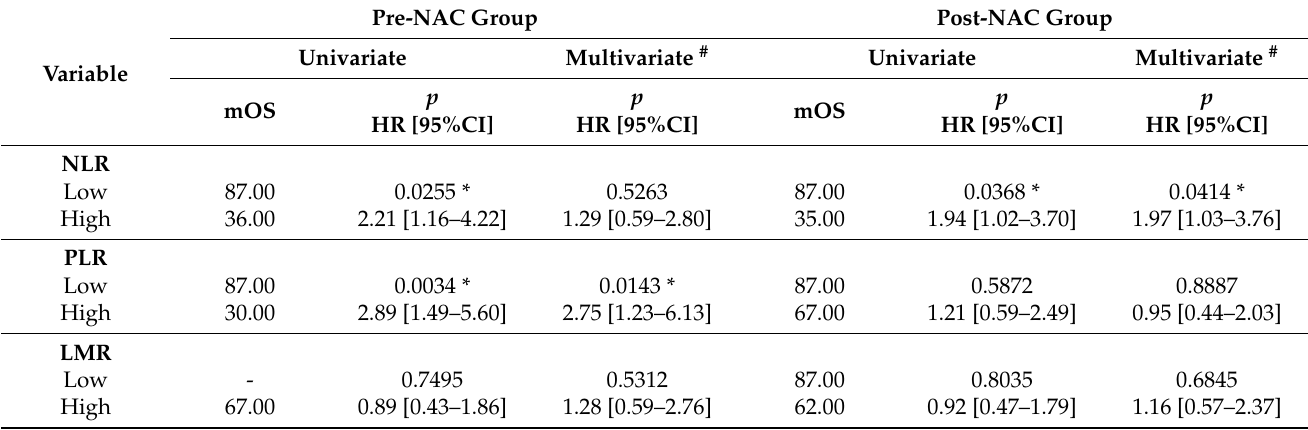
Table 2. Relationship between the systemic inflammatory response markers on overall survival.